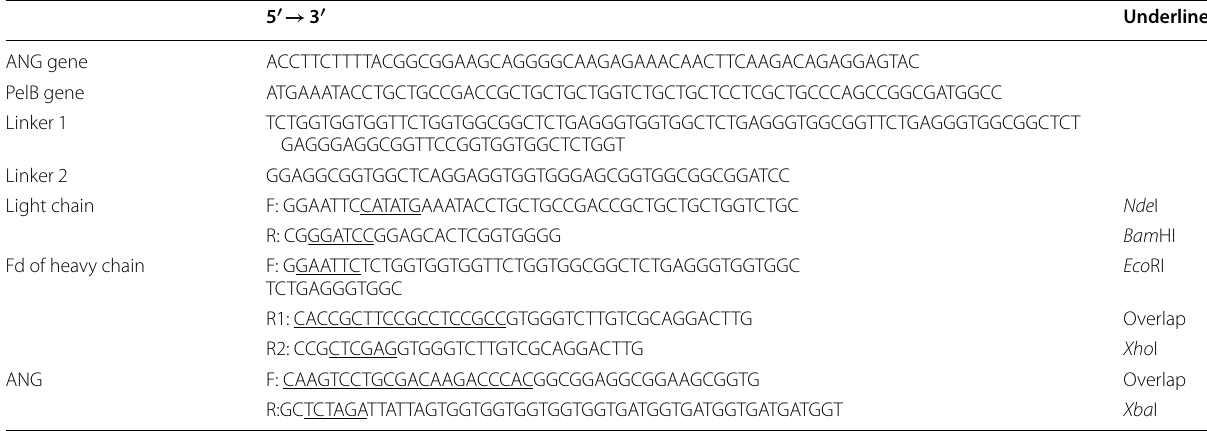
Table 1 The primers and gene sequences